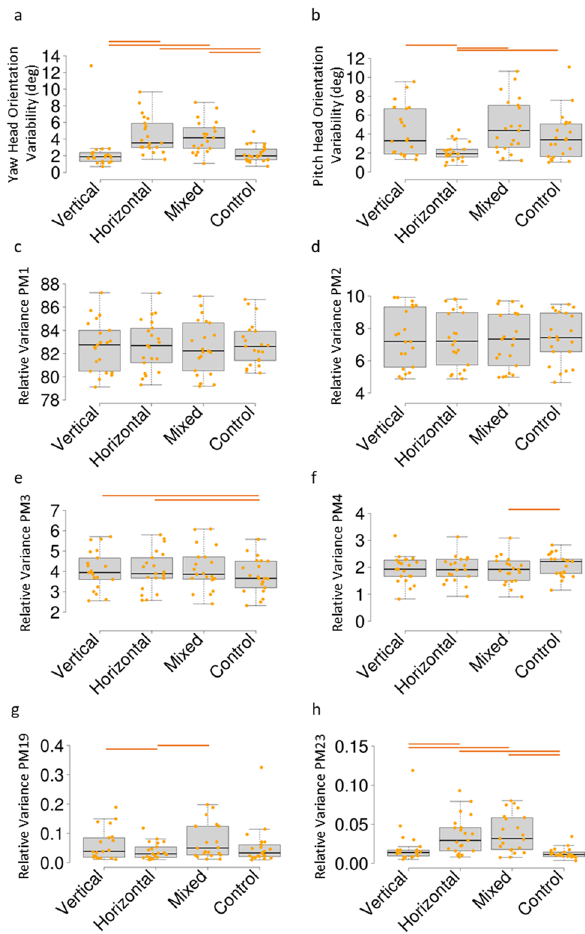
Figure 1. Boxplots of between condition effects of head movement variability ( a and b ), the main movement patterns identified by PCA (PM1–PM4, panel c–f ) and the two PMs mainly associated with head movements (PM19 and PM23, panel g and h ). Horizontal bars above panels indicate significant differences using pairwise t-testing (panel a and b ) and pairwise Durbin-Conover tests (panel c – h ), all with Bonferroni correction for multiple